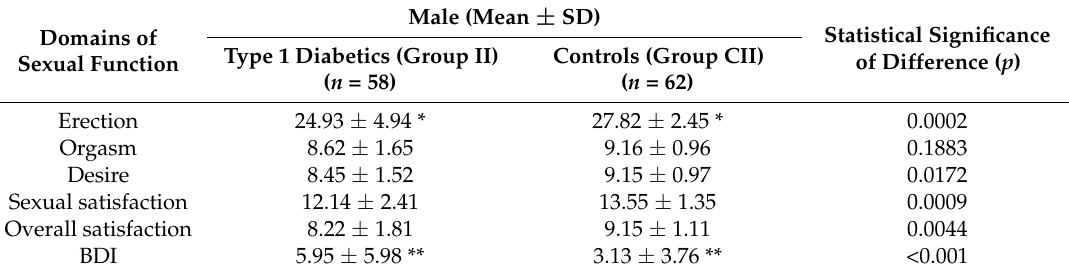
Table 3. Sexual function and Beck Depression Inventory (BDI) characteristics in diabetic men and controls.